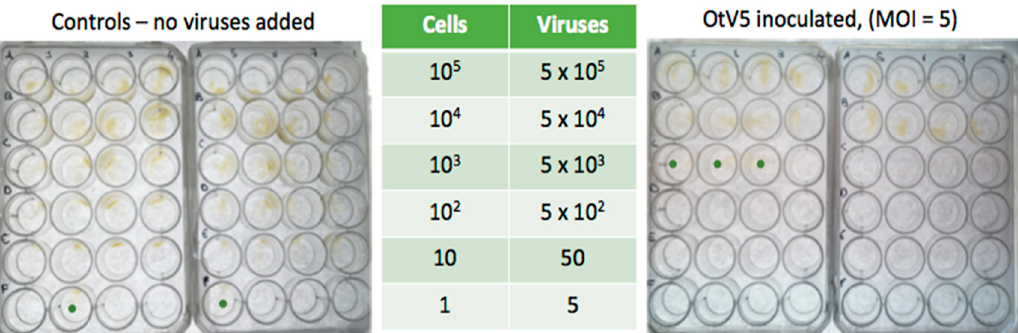
Figure 4. ( Left ): uninfected cultures. ( Right ): cells inoculated with OtV5 at MOI 5, as shown in the table. Each of the 16 columns of wells is a separate culture, diluted as shown in the table in rows top (least dilute) to bottom (most dilute). Green dots indicate the most dilute step of the series in which host cell growth was visible in a proportion of the cultures.